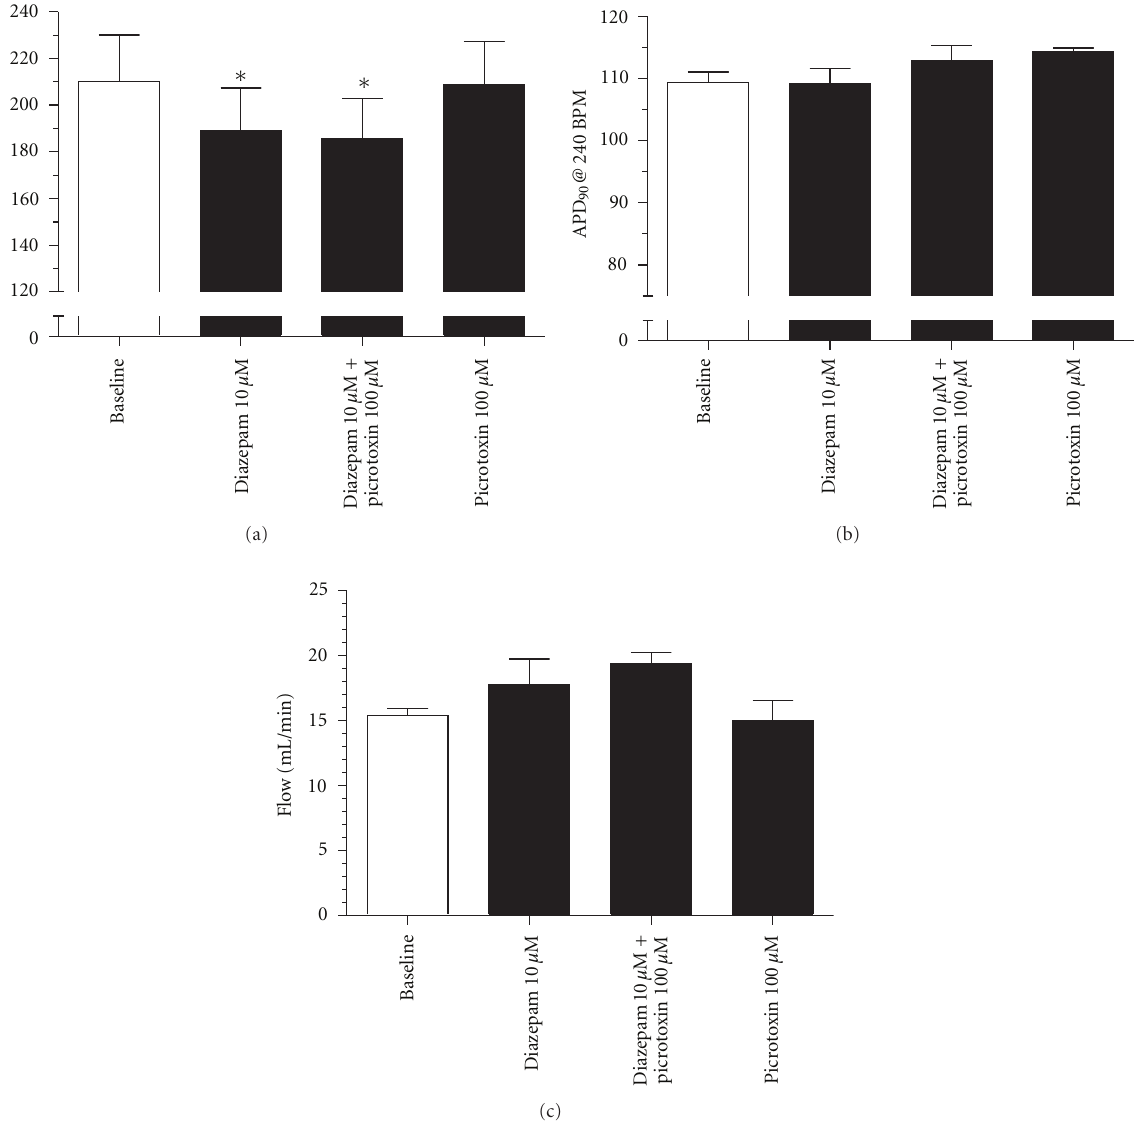
Figure 5: The e ff ect of diazepam (10 μ M), diazepam (10 μ M) + picrotoxin (100 μ M) (co-administration), and picrotoxin (100 μ M) on heart rate (a), action potential duration (b), and coronary flow (c). Hearts were left to stabilize for a minimum of 30 min. 20min of baseline recordings were performed, where heart rate and flow were monitored. The hearts were then paced from the right atrium at 240 BPM for 2min in order to measure the action potential duration at a fixed heart rate. This (20+2) protocol was repeated for the di ff erent drugs investigated ( n = 5; ∗ P ≤ 0 . 05 (1-way ANOVA); (715 ± 129